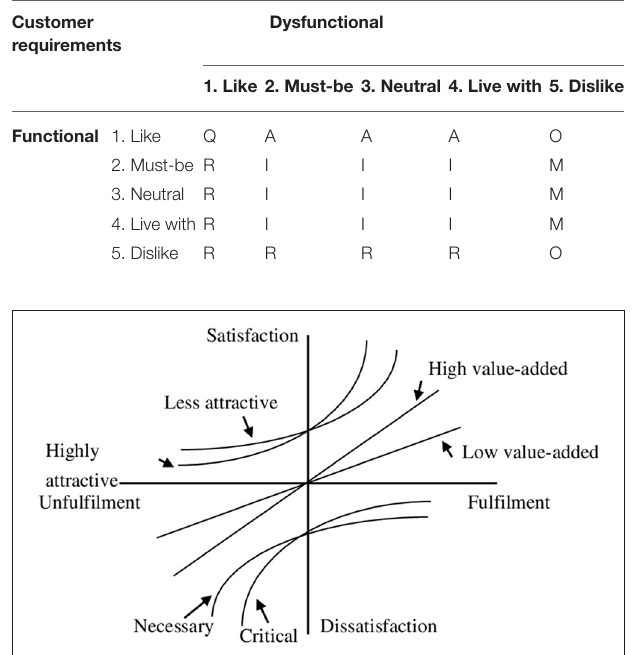
TABLE 2 | Kano evaluation table.